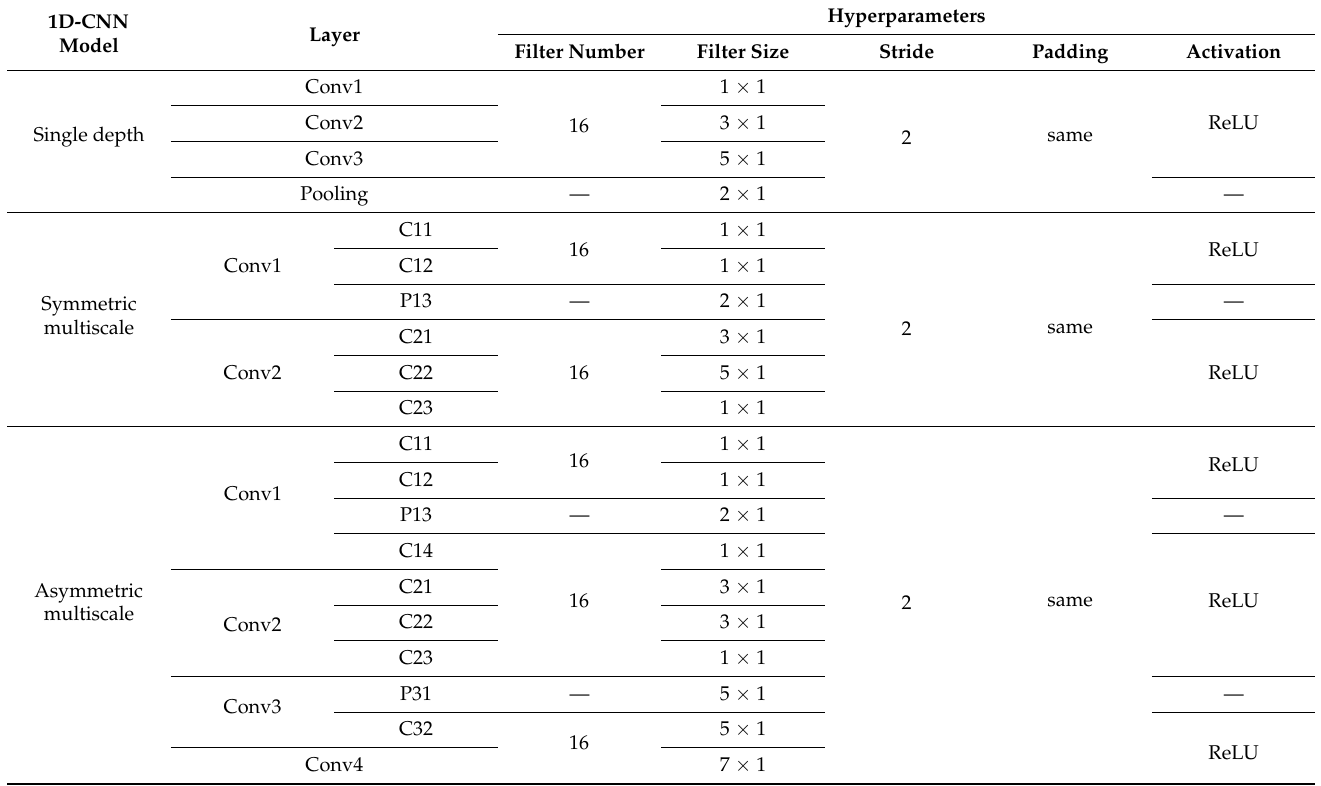
Table 1. Hyperparameters used in network layers.